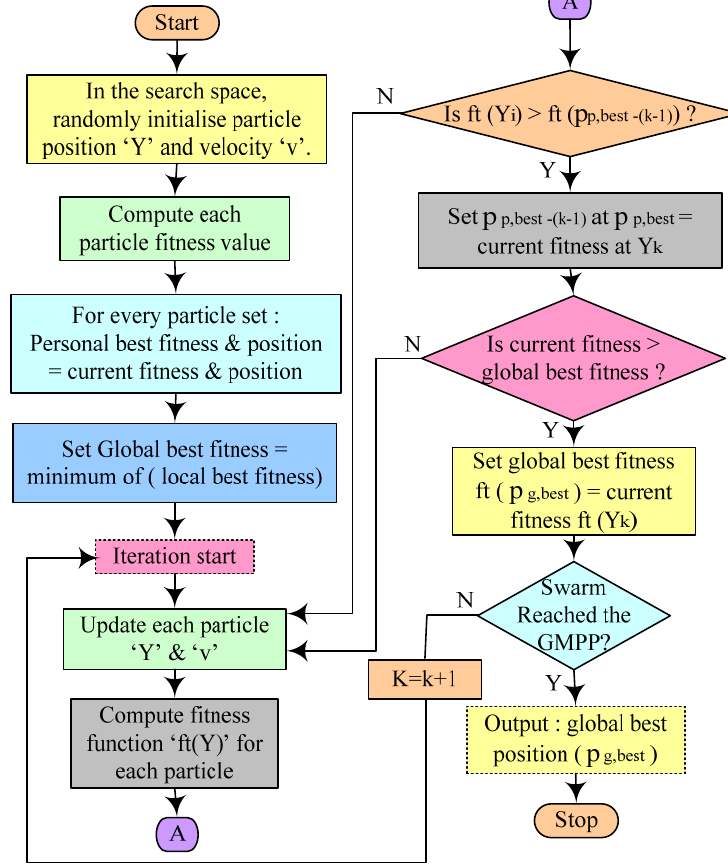
Figure 13. PSO-based MPPT technique